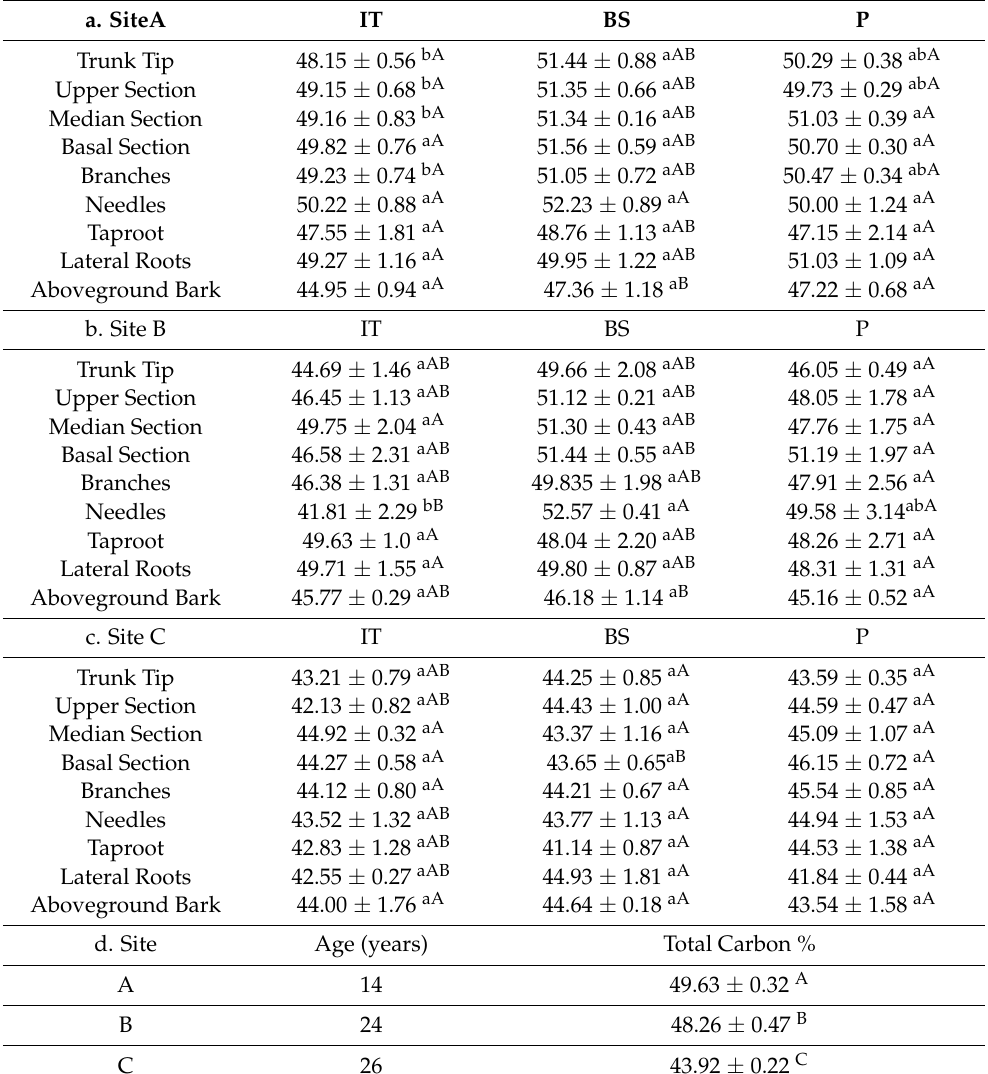
Table 3. Carbon percentage in slash pine